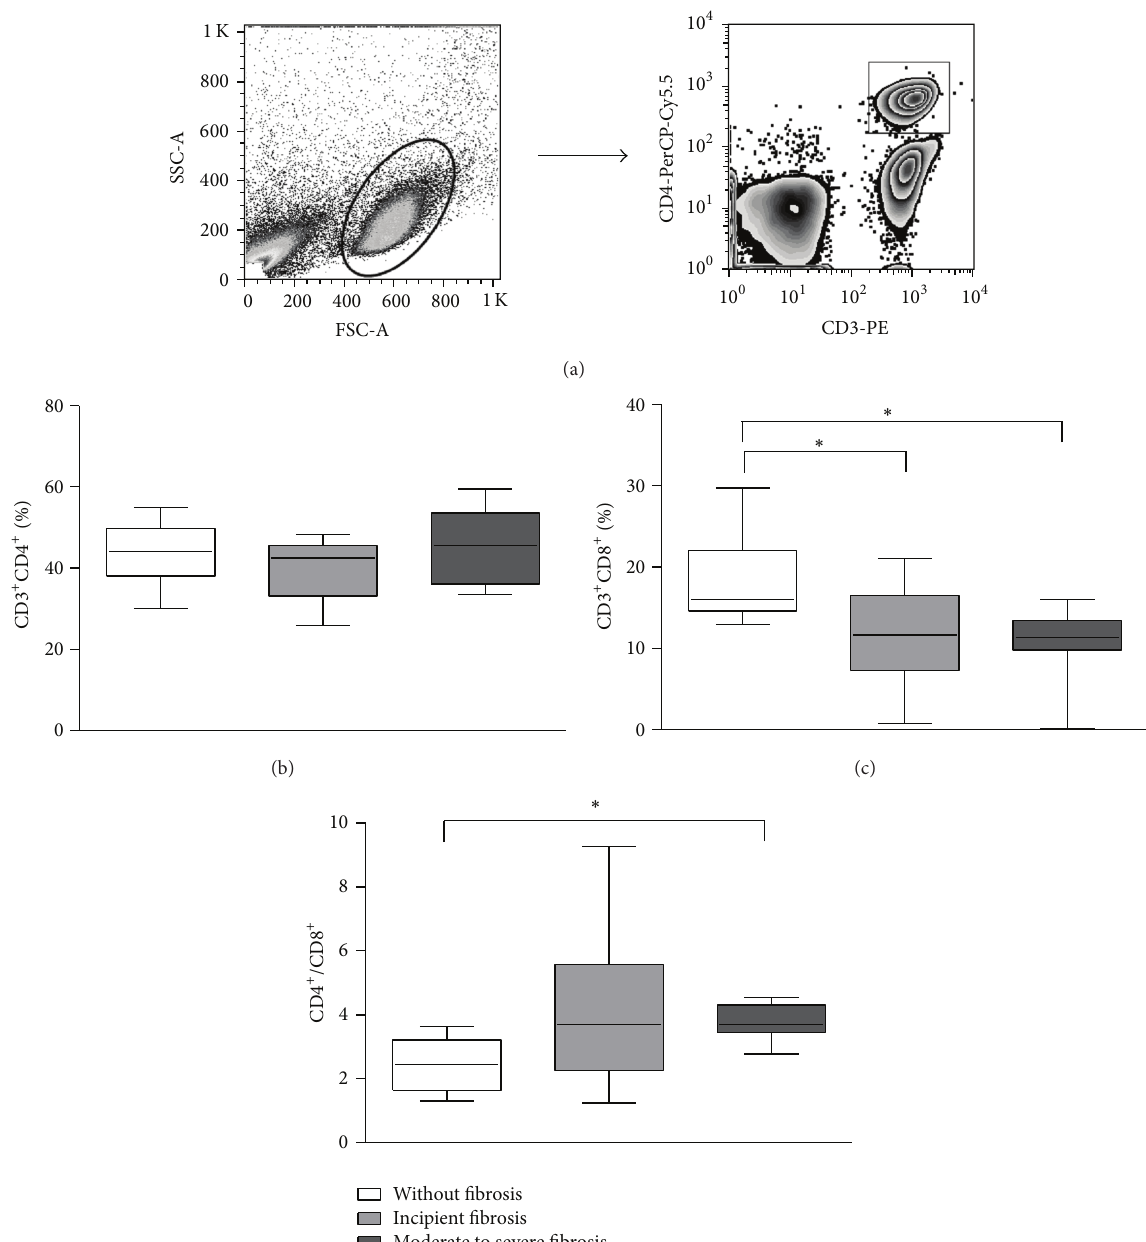
Figure 1: Strategy for T cell evaluation by flow cytometry. The cell populations were defined by nonspecific fluorescence from the forward (FSC) and side scatter (SSC) as parameters of cell size and granularity, respectively (a). Lymphocyte regions were determined through the expression of CD3-PE and CD4-PeCy7 (b) or CD3-PE and CD8-FITC (c). Frequency of TCD 4 + cells and TCD 8 + cells and ratio between TCD 4 + and TCD 8 + cells (d) in individuals infected with S. mansoni with different degrees of periportal fibrosis. Results are expressed in median, minimum, maximum, and interquartile values of frequency ( ∗ 𝑃 < 0.05 ; Kruskal-Wallis